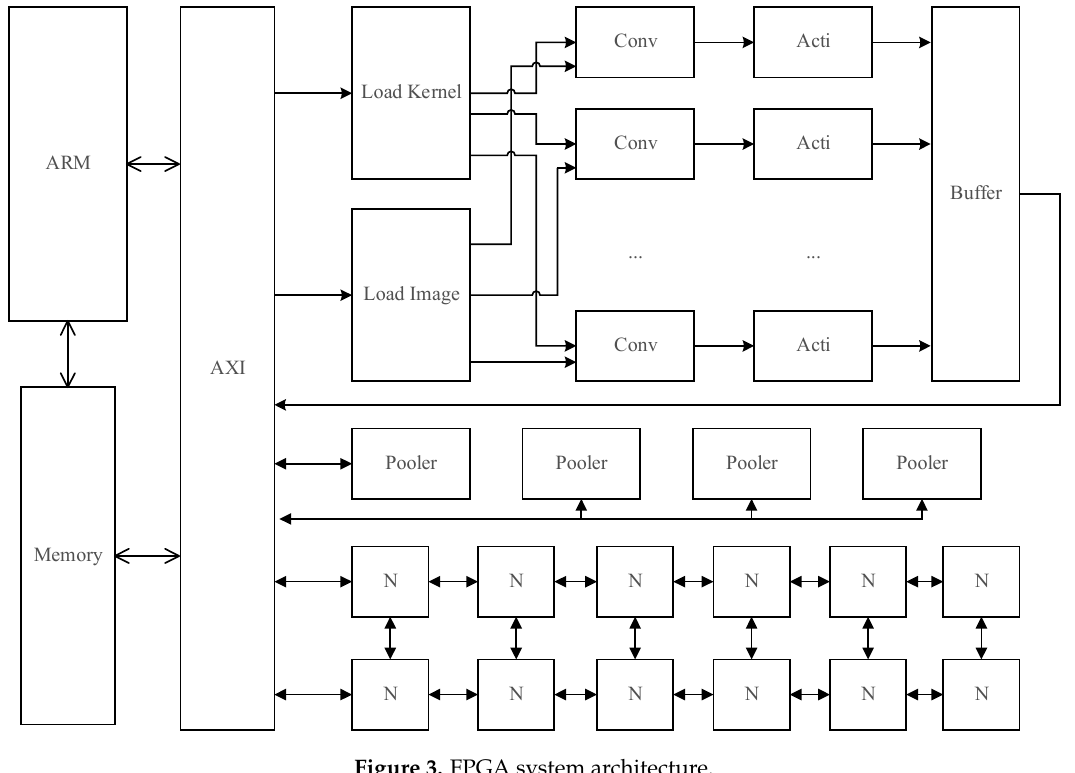
Figure 3. FPGA system architecture.